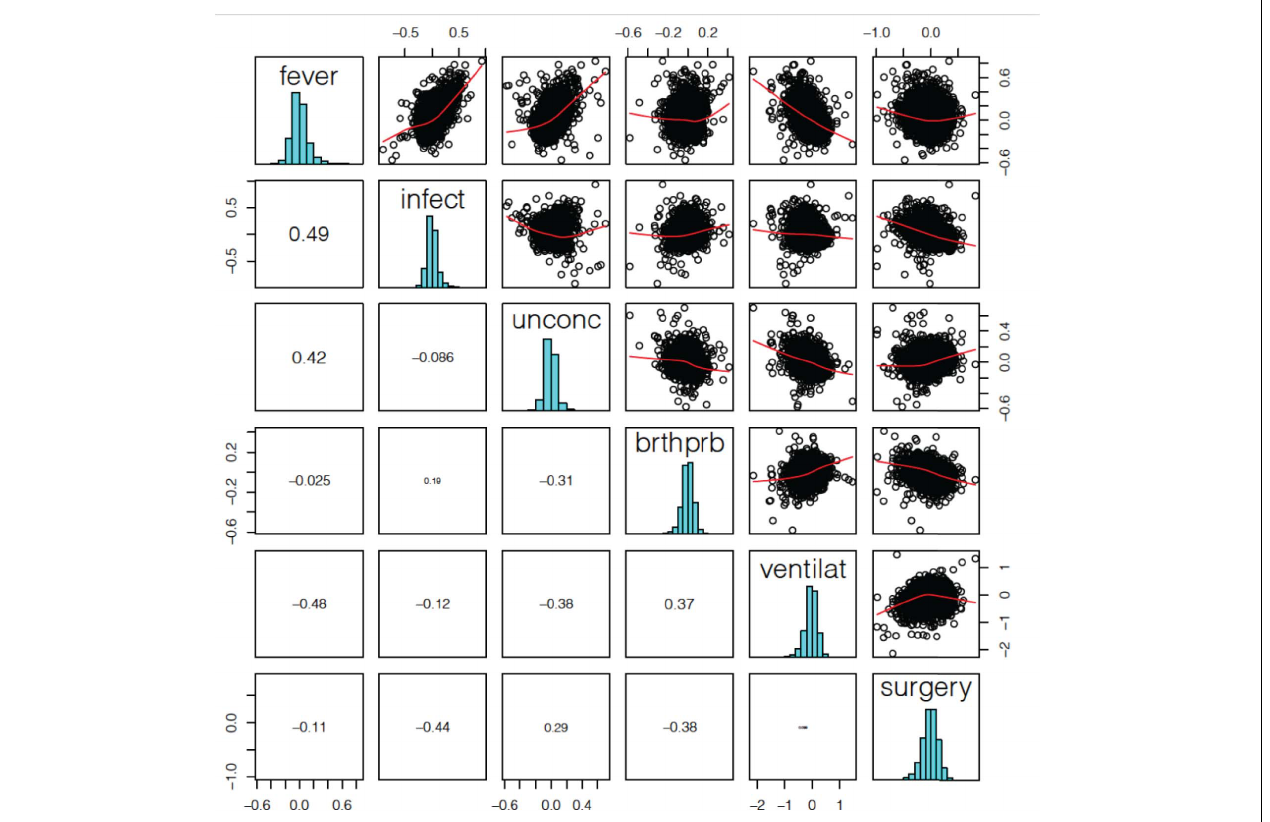
FIGURE 3 | Terminal state associated differentially expressed gene (DEG) log2-FC effect size correlation. We found a significant positive correlation between fever and infection, difficulty breathing and artificial ventilation. We also a found negative correlation between fever and ventilation, infection and surgery, and unconsciousness and